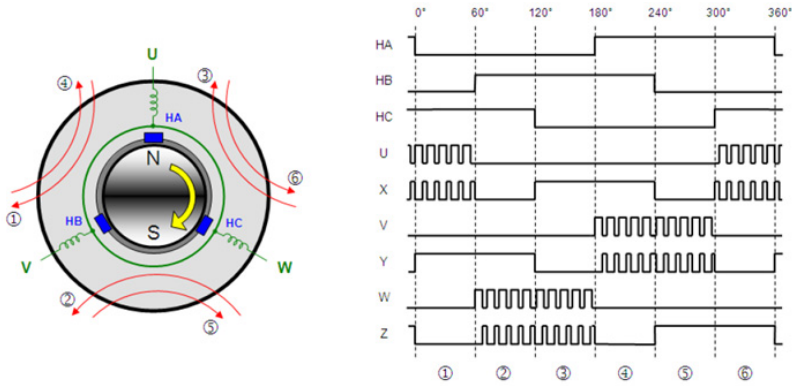
Figure 8. PWM-PWM Commutation at CW/CCW = 1.